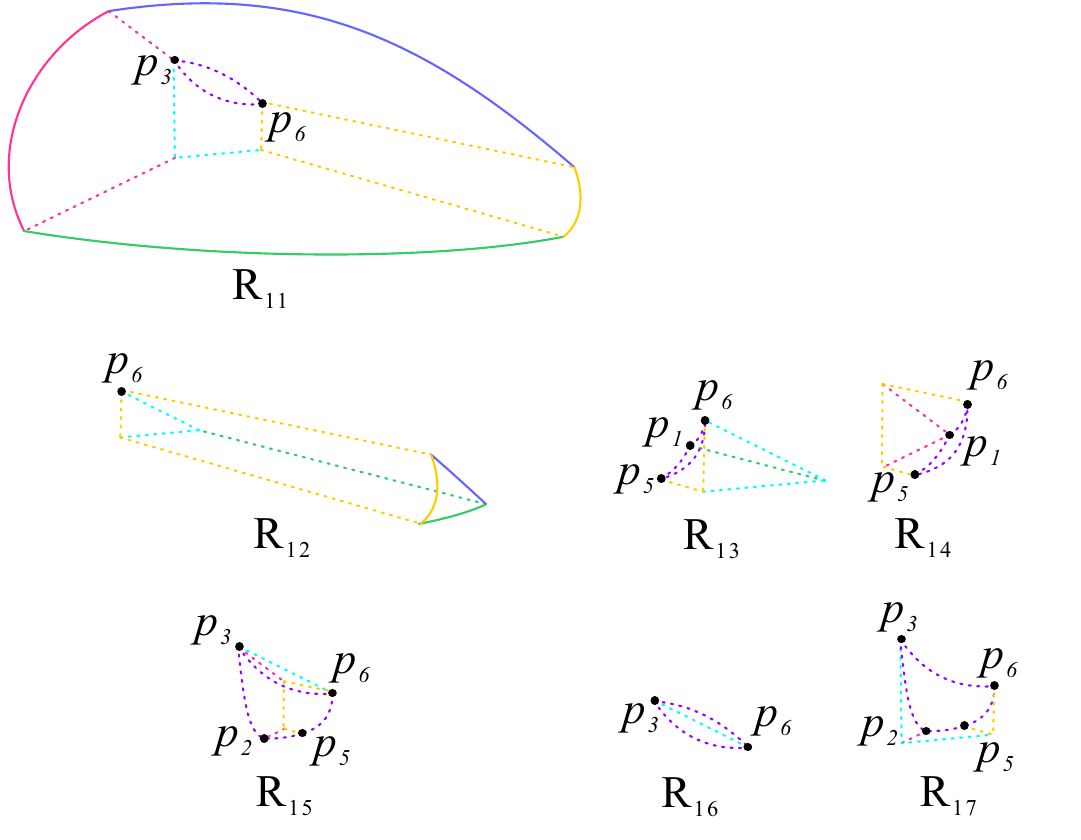
Figure 3. The region R 1 is divided into seven subregions by the five planes y = 0, z = 0, Ω ( m ) = 0, b 2 = 0, and b 3 = 0, and one surface b 1 =